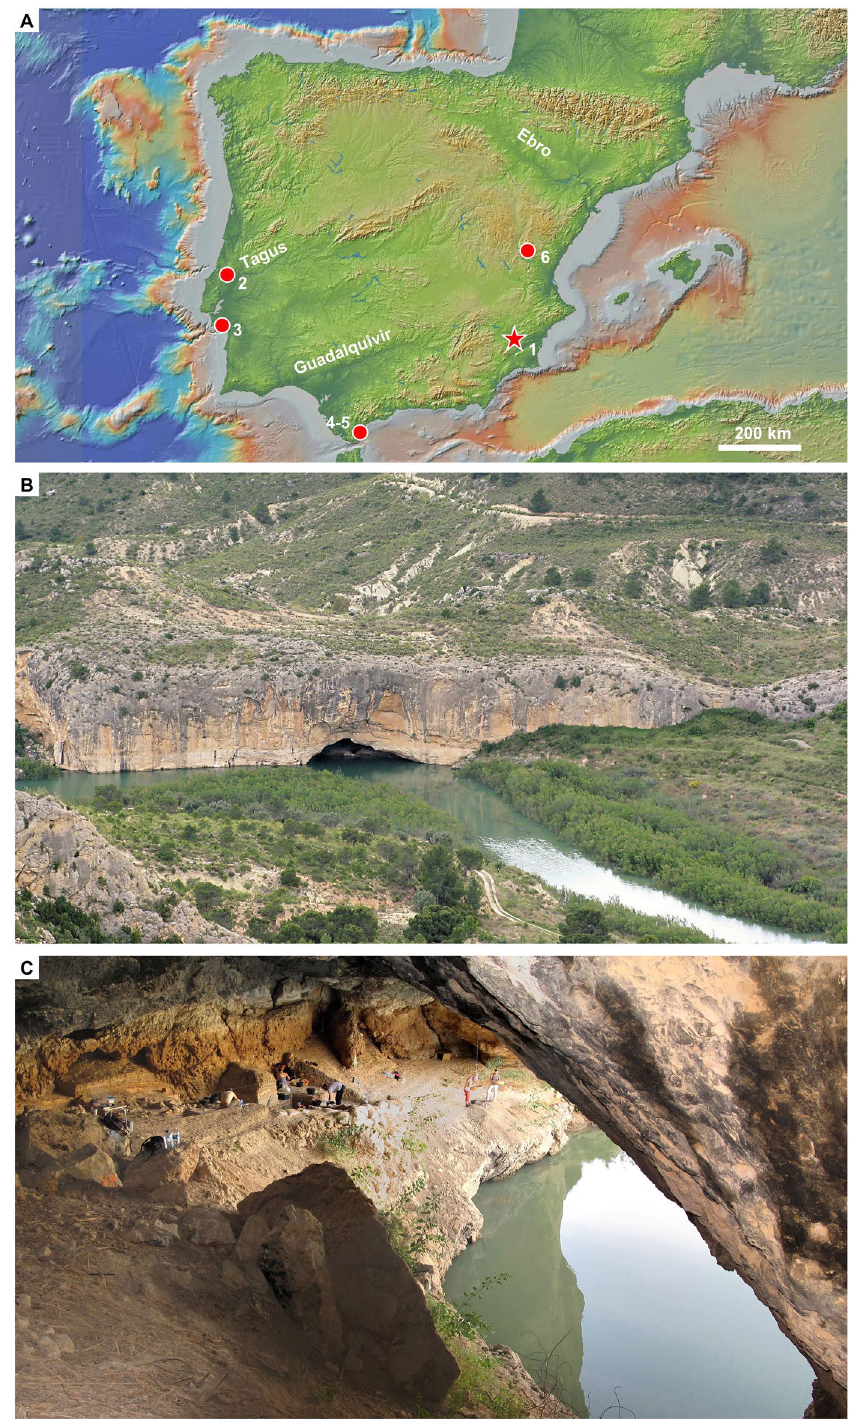
Figure 1. Location. ( A ) MIS 5 Iberian Middle Paleolithic sites mentioned in the text. 1. Cueva Antón; 2. Gruta da Oliveira; 3. Gruta da Figueira Brava; 4. Gorham’s Cave; 5. Vanguard Cave; 6. Abrigo de la Quebrada. Base map: Global Multi-Resolution Topography Synthesis (https:// www. gmrt. org/ GMRTM apTool/) ( 70 ). ( B ) Exterior view of Cueva Antón from the North (2009). ( C ) Interior view of Cueva Antón from the East (2012 field